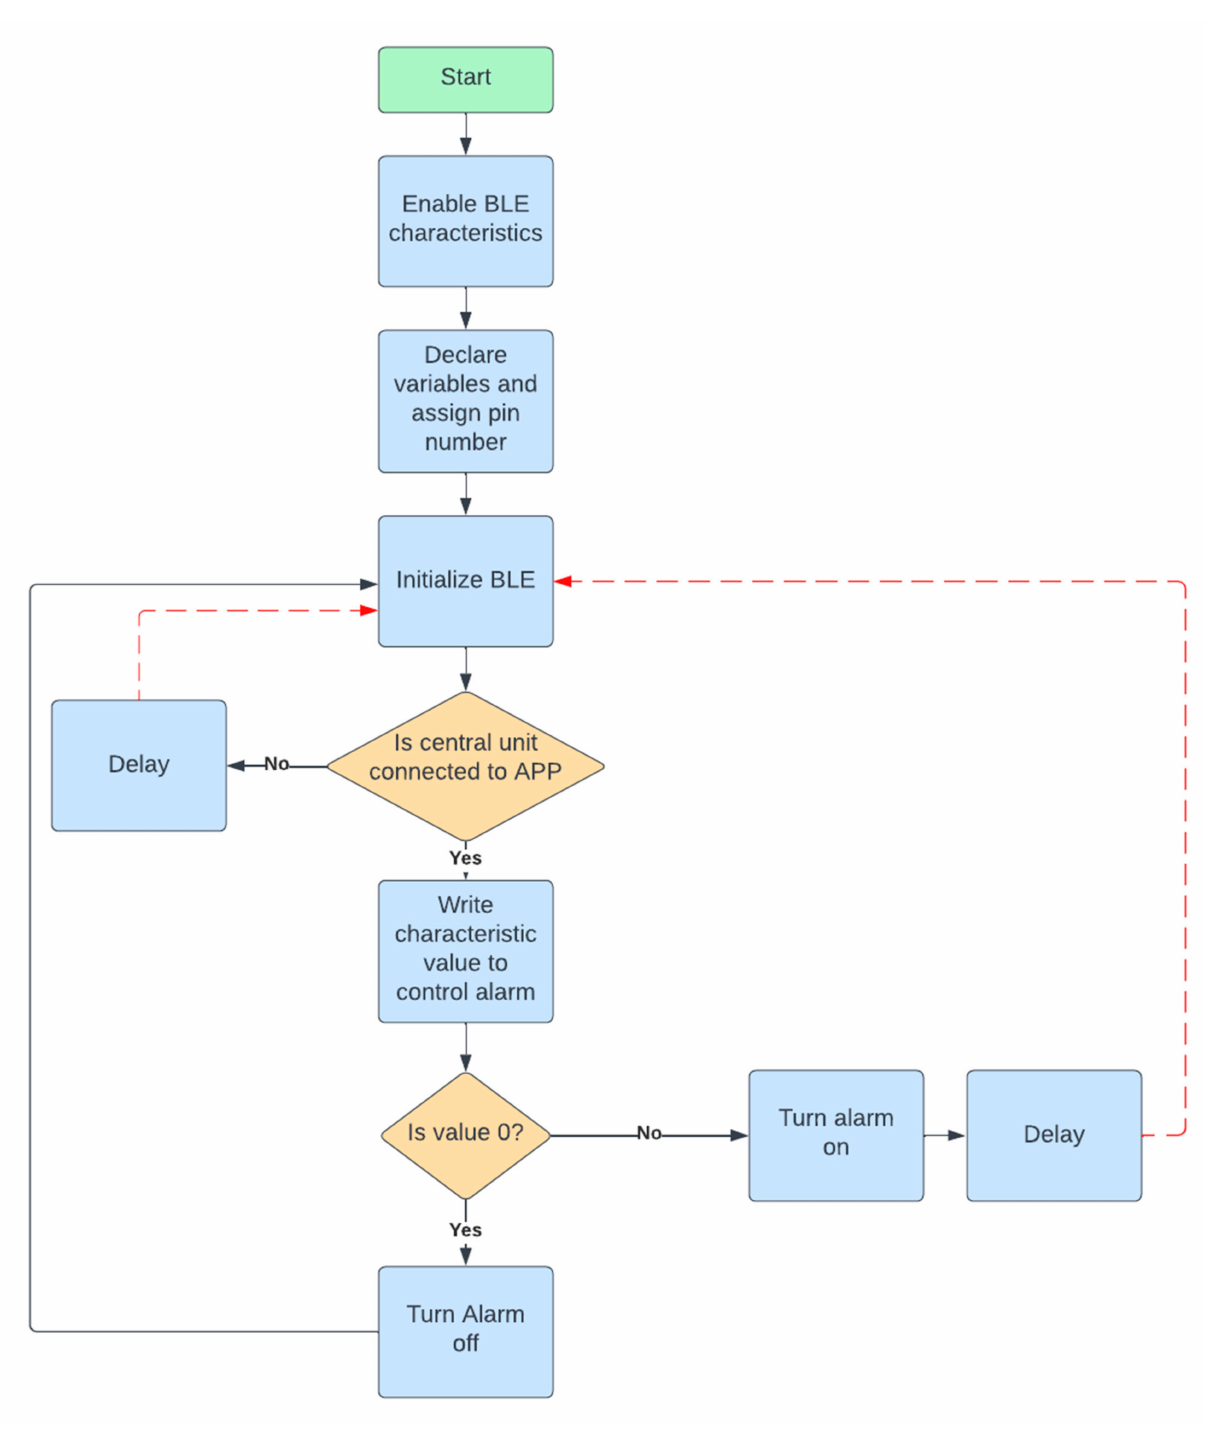
Figure 6. DiAtack Central Unit Software